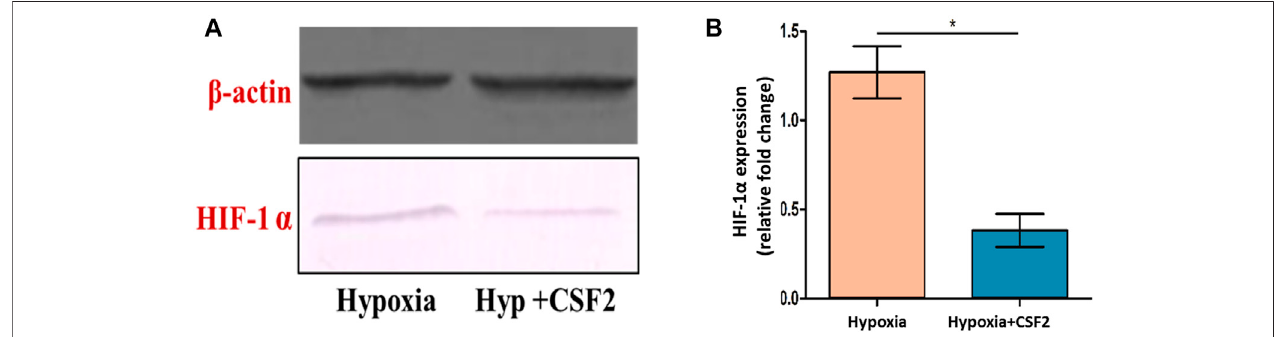
FIGURE 10 | Western blot showing level of hypoxia inducible factor-1 alpha (HIF-1 α ) ( A ), which otherwise elevated under hypoxia stress, was decreased after supplementation with CSF2 ( B ). Hypoxia+CSF2 indicates supplementation of 100 µg/ml of CSF2 extract in HEK 293 cells being cultured in low oxygen tension (0.5% O 2 ). Results are expressed as mean ± SD ( n (cid:1) 3). * represents signi fi cant change at level p <